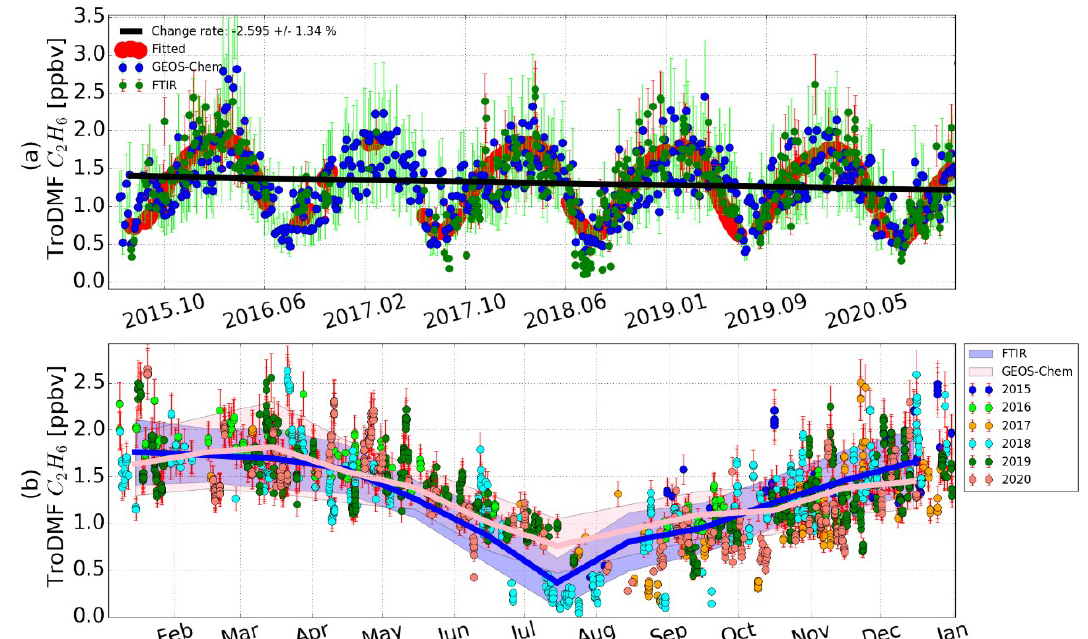
Figure 3. (a) C 2 H 6 troDMF time series comparison between the FTIR observation and GEOS-Chem model BASE simulation from 2015 to 2020 over Hefei, eastern China. The seasonality and interannual variability are represented by red dots and a black line, respectively, which are fitted using a bootstrap resampling model with a third Fourier series and a linear function. (b) Seasonal variations in C 2 H 6 troDMF by FTIR and GEOS-Chem simulation. The bold curves and the shadows are the monthly mean values and the 1 σ standard variations, respectively. Vertical error bars for FTIR and GEOS-Chem represent retrieval uncertainties and diurnal variabilities, respectively. A retrieval error of 6.21% in Table 1 was used to estimate the absolute uncertainties of all observations. As a result, the absolute uncertainties in winter are larger than those in summer due to a higher C 2 H 6 level in the